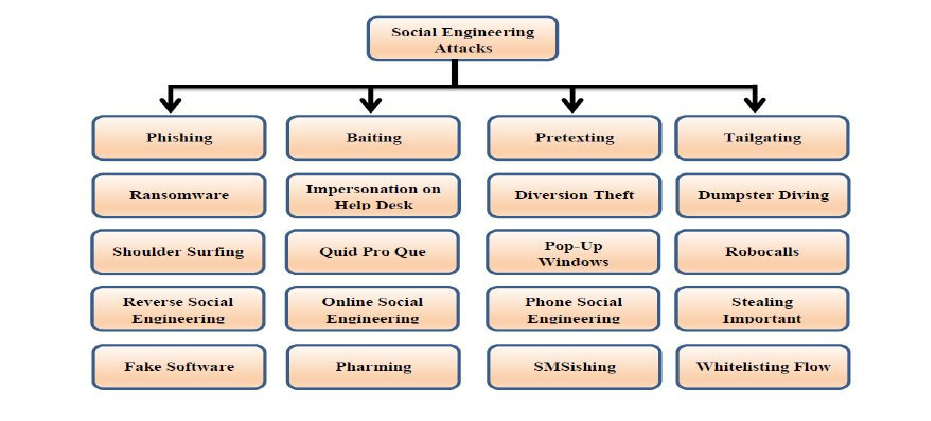
Fig. 1. SE Attacks